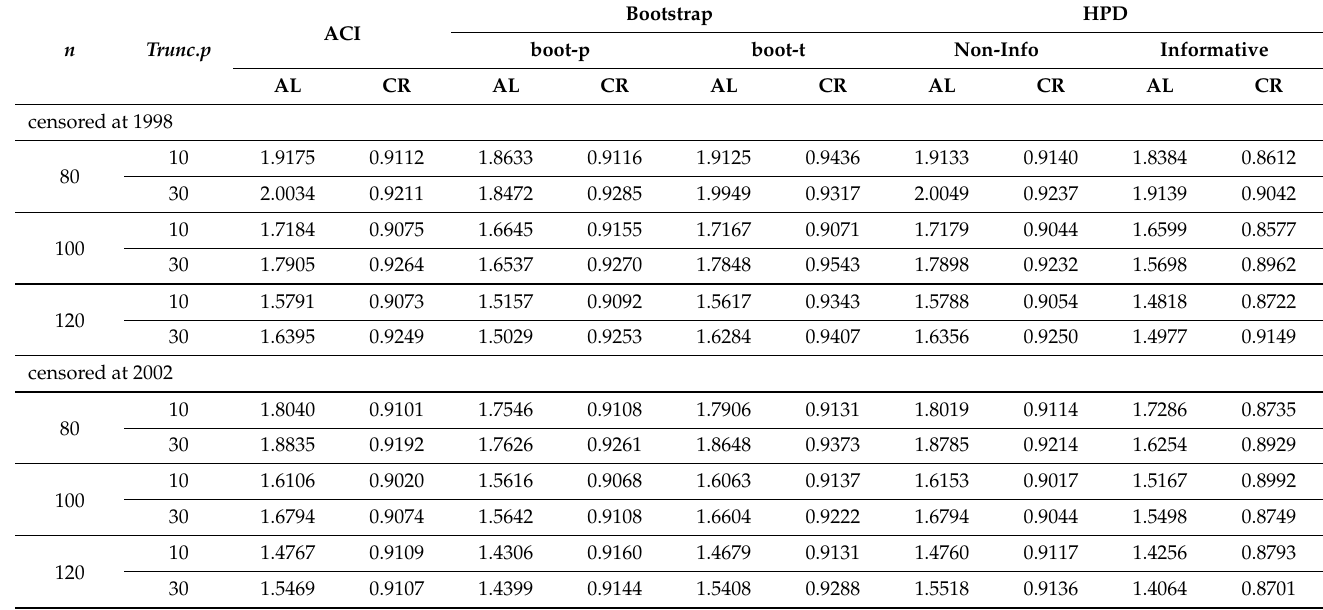
Table A5. The simulation results of five intervals for σ at 90% confidence/credible level.